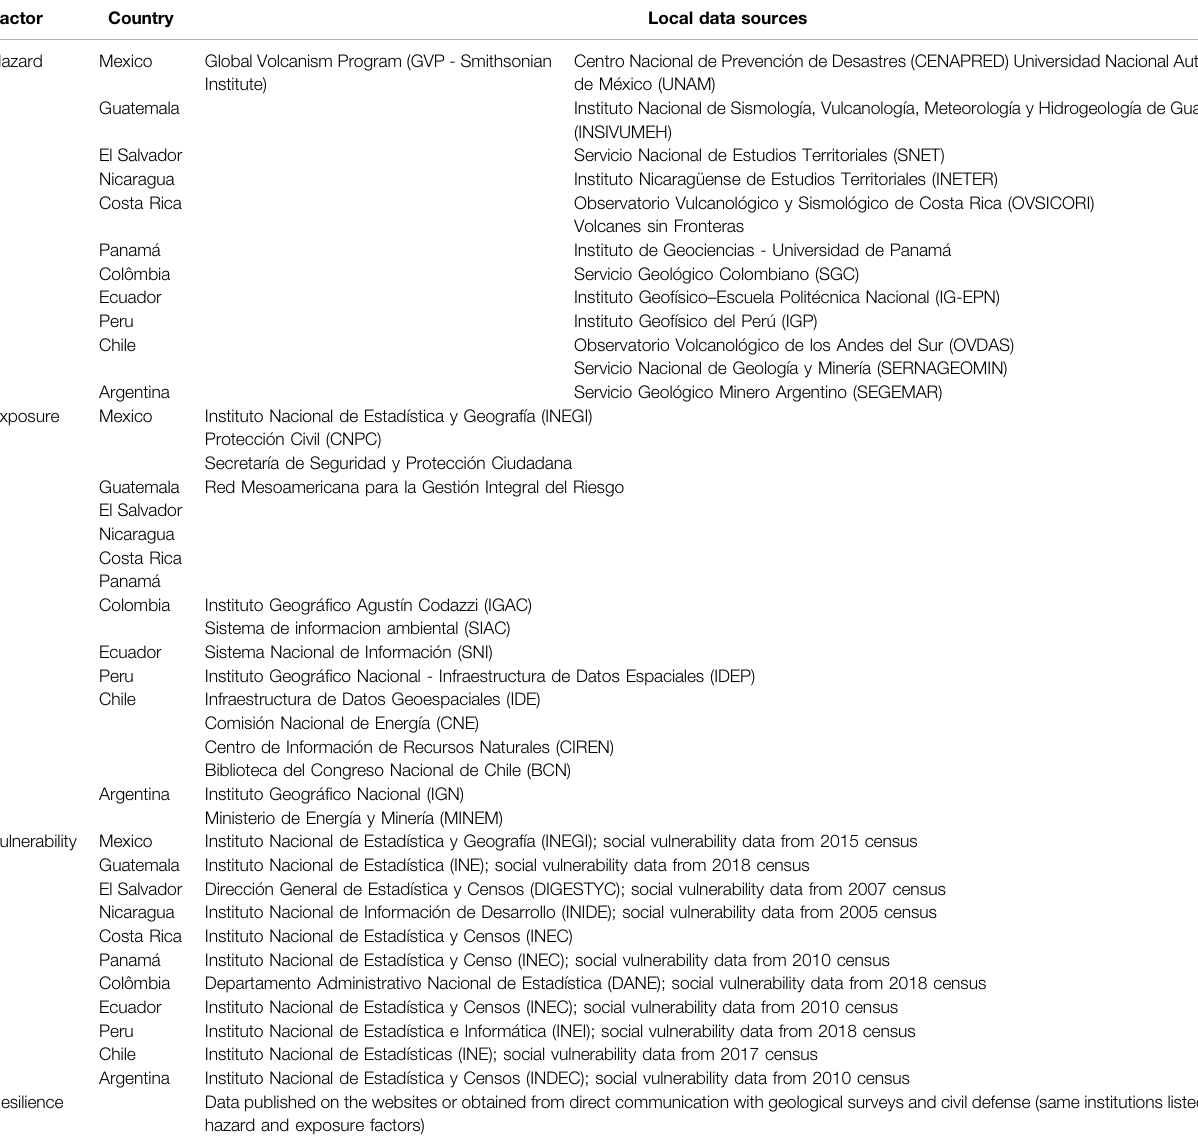
TABLE 2 | List of local institutions, separated by country, used for data acquisition on hazard, exposure, vulnerability and resilience factors. Factor Country Local data